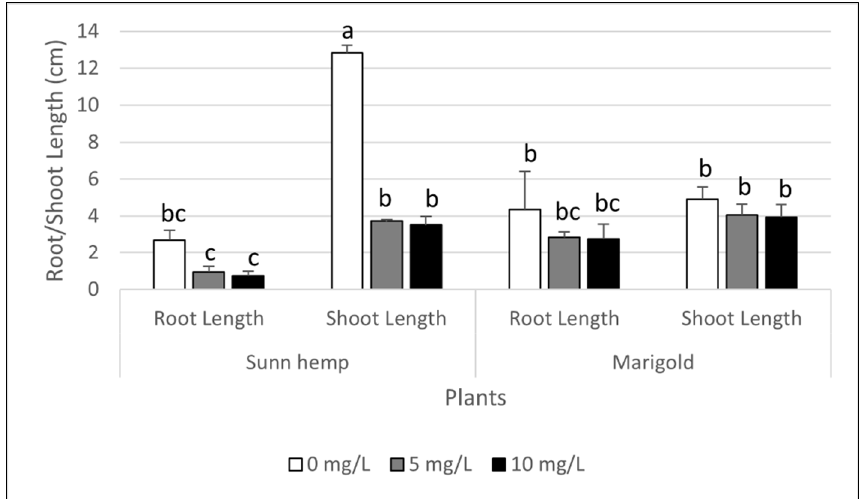
Figure 8. Seed germination test for the length of shoot and root of sunn hemp and marigold exposed to carbaryl concentrations of 0, 5 and 10 mg L −1 . Note: a, b and c indicate significant differences based on ANOVA and a Tukey HSD test. The data shown are mean and SD.